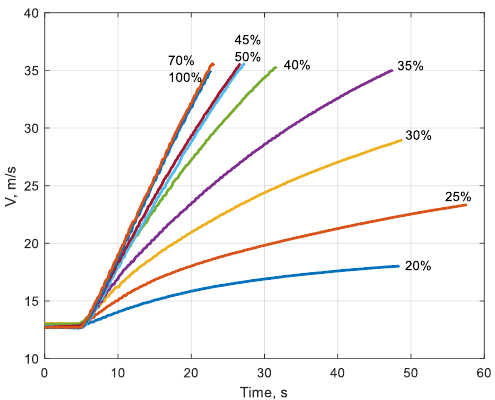
Fig. 3. Courses of linear speed car in the flexibility test during acceleration of a constant transmission on the test bench for constant throttle positions